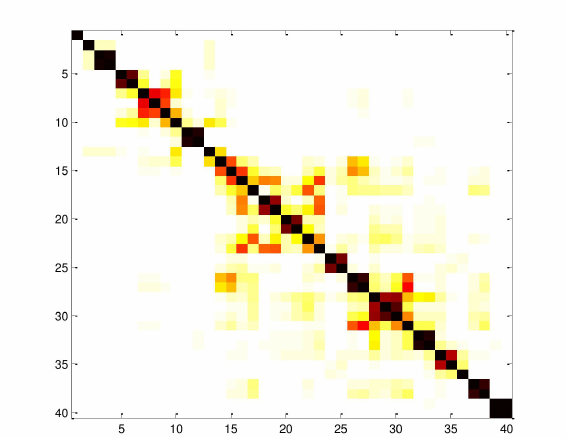
Figure 6. Matrix of w-correlation example.